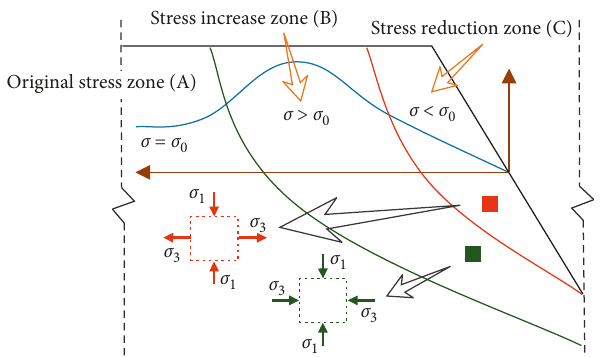
Figure 1: Sketch of stresses in different parts of the slope [14].